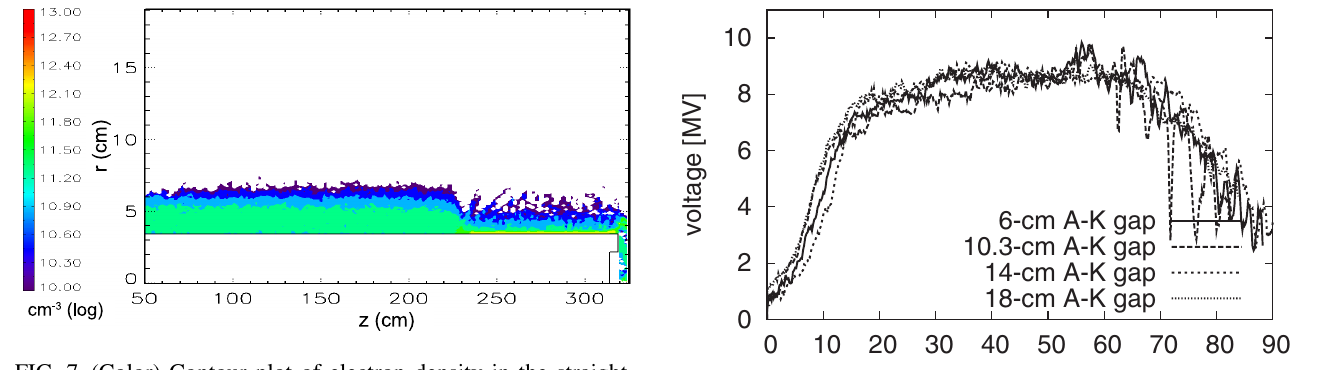
FIG. 7. (Color) Contour plot of electron density in the straight transmission-line geometry with a 5.9-cm A-K gap. Density shown is at 30 ns into the pulse. The retrapping wave, located at z (cid:7) 225 cm in the figure, originates at the diode and prop- agates upstream. The spatial resolution is identical in all simu-